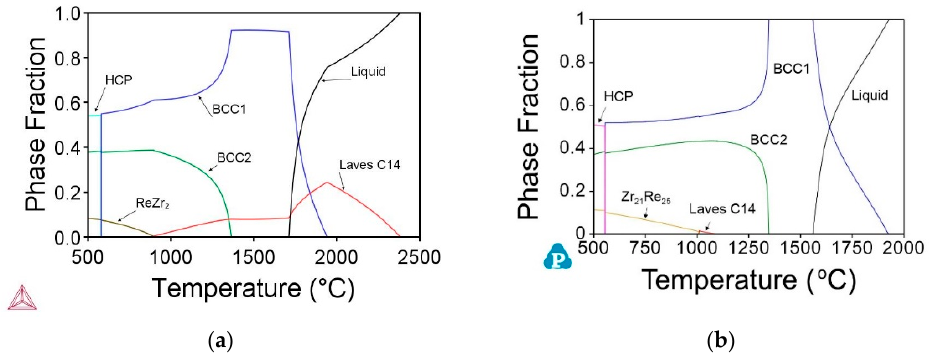
Figure 16. Equilibrium phase diagrams of Re 0.3 TaTiZr using the ( a ) TCHEA4.1 database and ( b ) PanNb2020 database. ( b ) PanNb2020